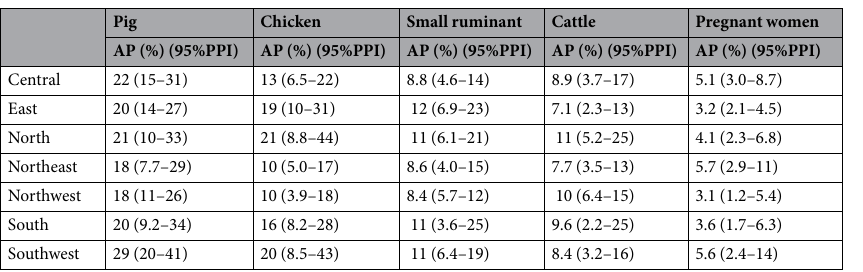
Table 2. Hierarchical model estimates for T. gondii apparent seroprevalence (%) in pregnant women and livestock in mainland of China, by region. AP: apparent seroprevalence; PPI: posterior probability